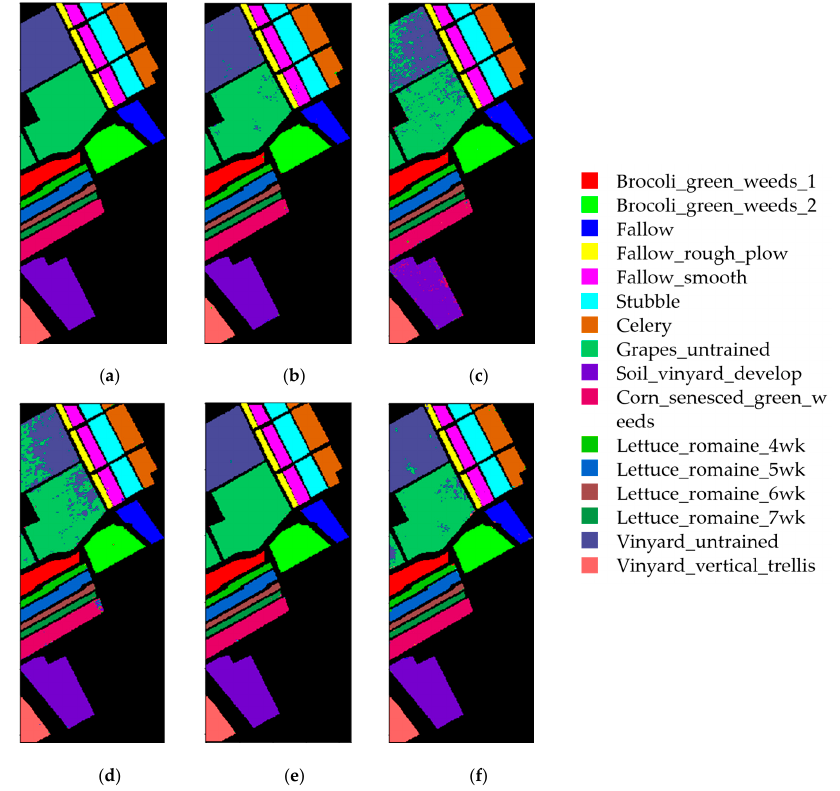
Figure 12. The classification map for the Salinas dataset of different networks . ( a ) ground truth; ( b ) SAE (OA: 99.29%); ( c ) 1D-CNN (OA: 94.46%); ( d ) 3D-CNN (OA: 92.87%); ( e ) DC-CNN (OA: 99.89%); ( f ) S2FEF-CNN (OA: